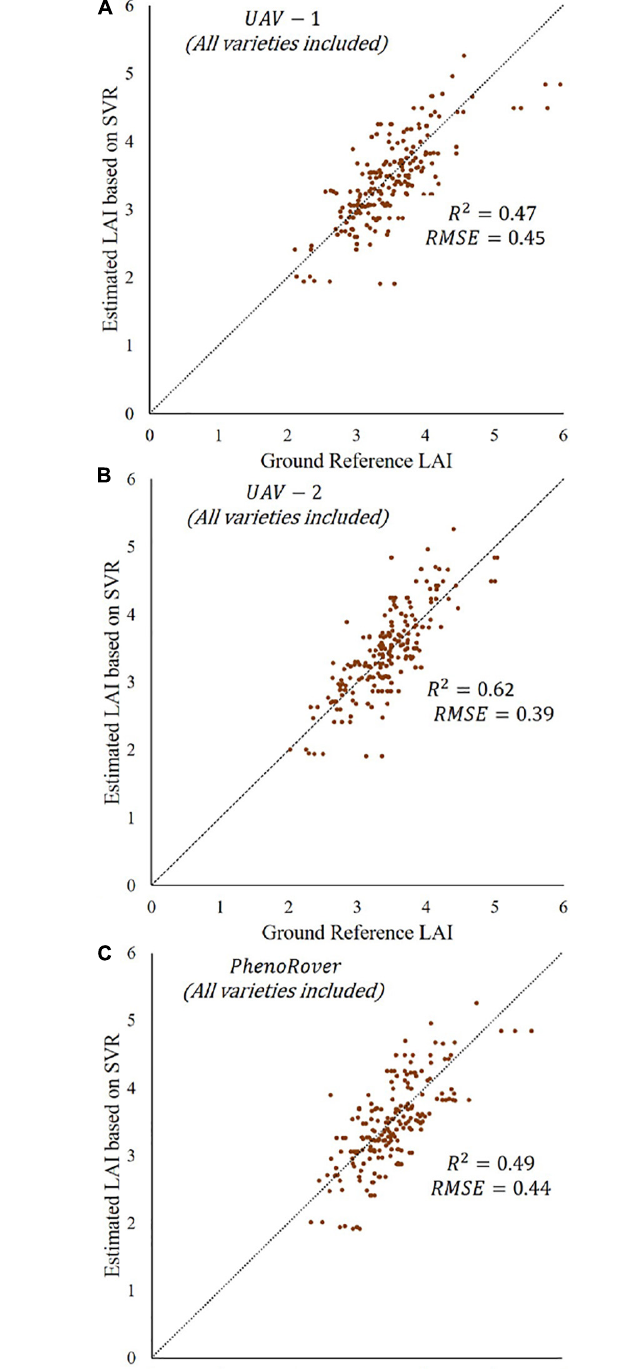
Frontiers in Plant Science |